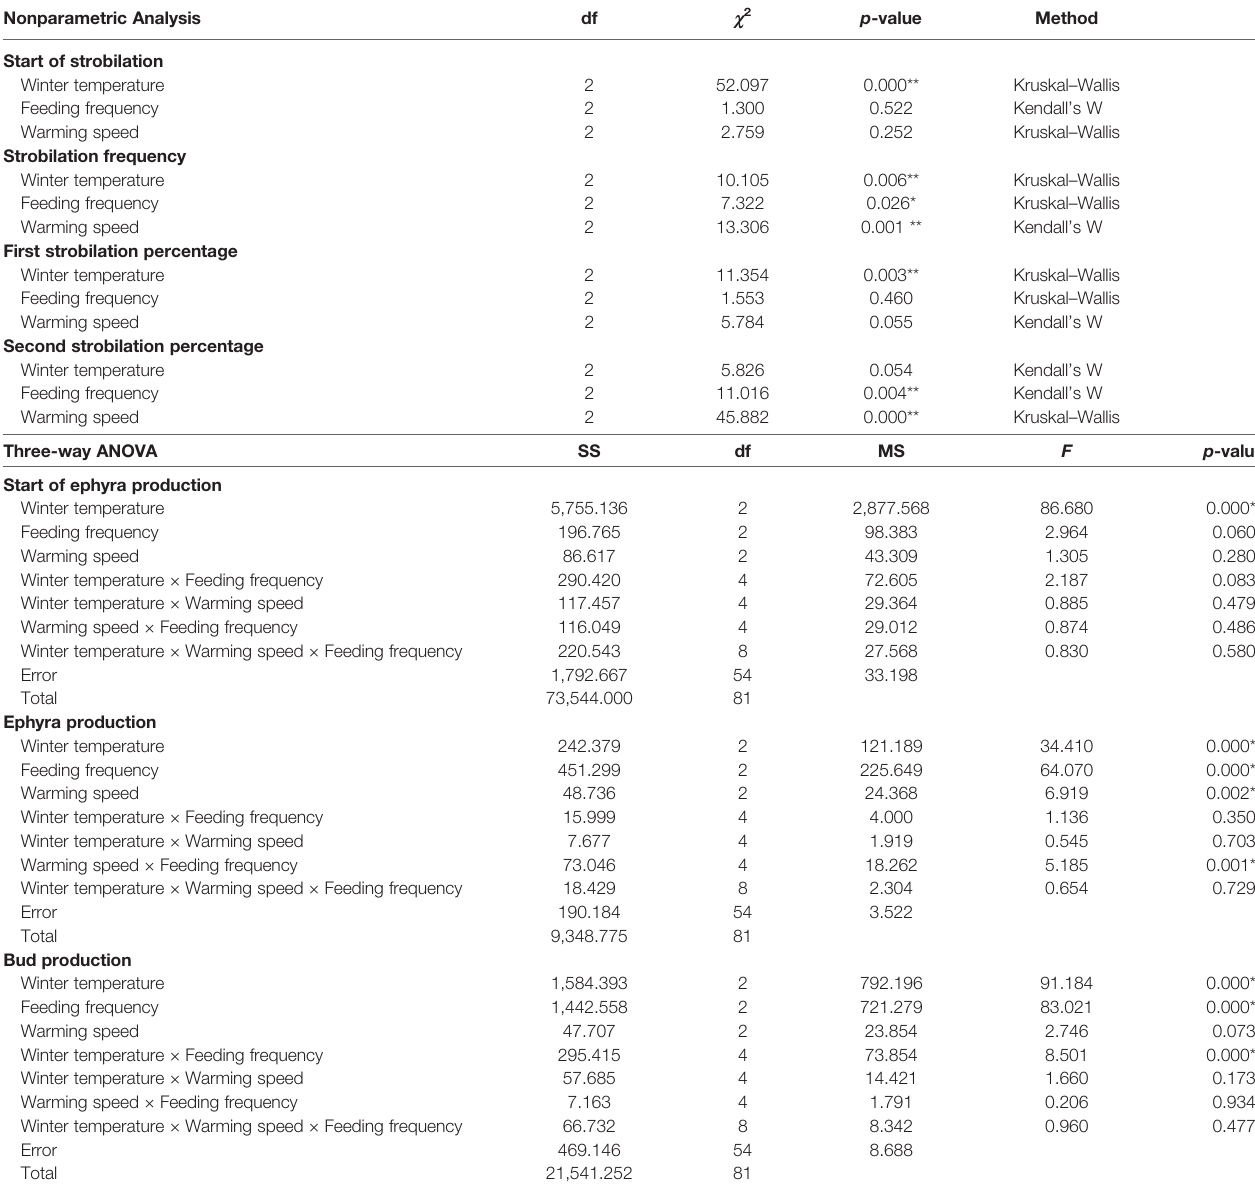
TABLE 1 | Summary of nonparametric analysis and three-way ANOVA results among winter temperature, warming speed, and feeding frequency on the start of strobilation, strobilation frequency, fi rst and second strobilation percentage, start of ephyra production, ephyra production, and bud production. Nonparametric Analysis